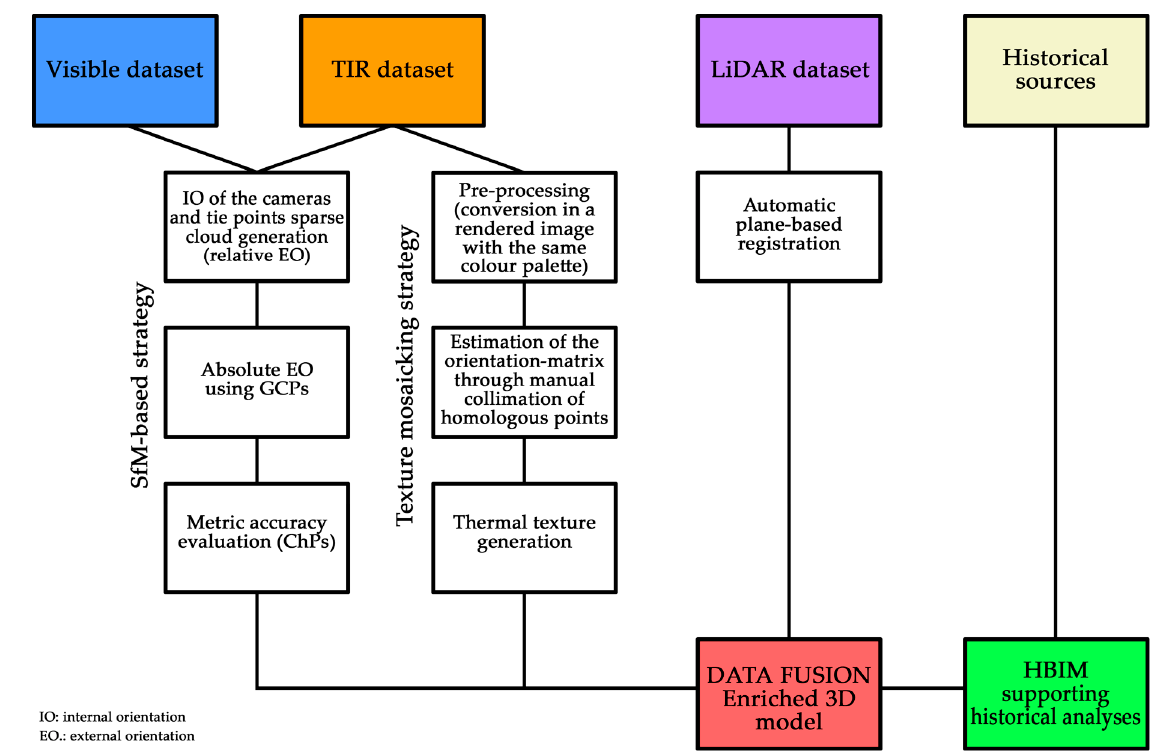
Figure 6. Flowchart of the followed workflows.